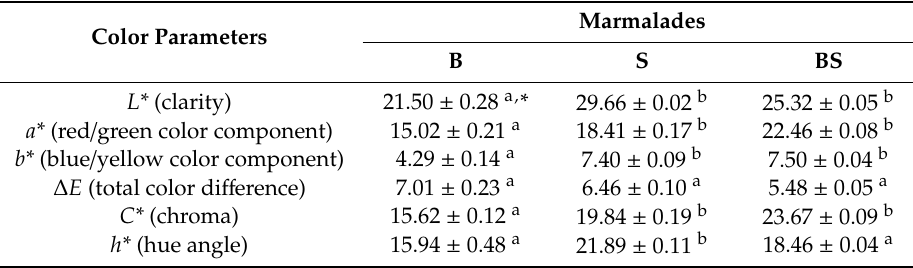
Table 2. Color parameters of